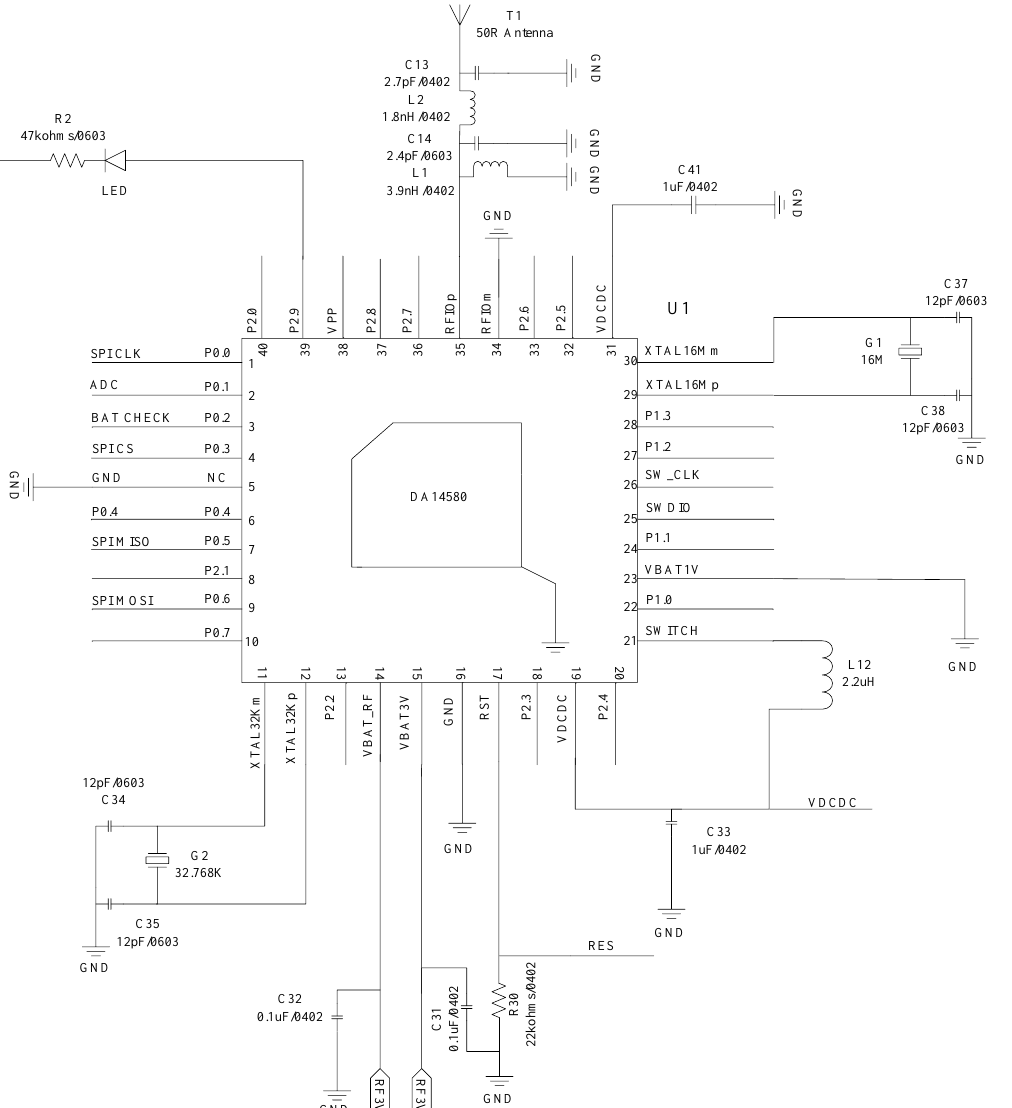
Figure 7. Peripheral circuit of the MCU chip.